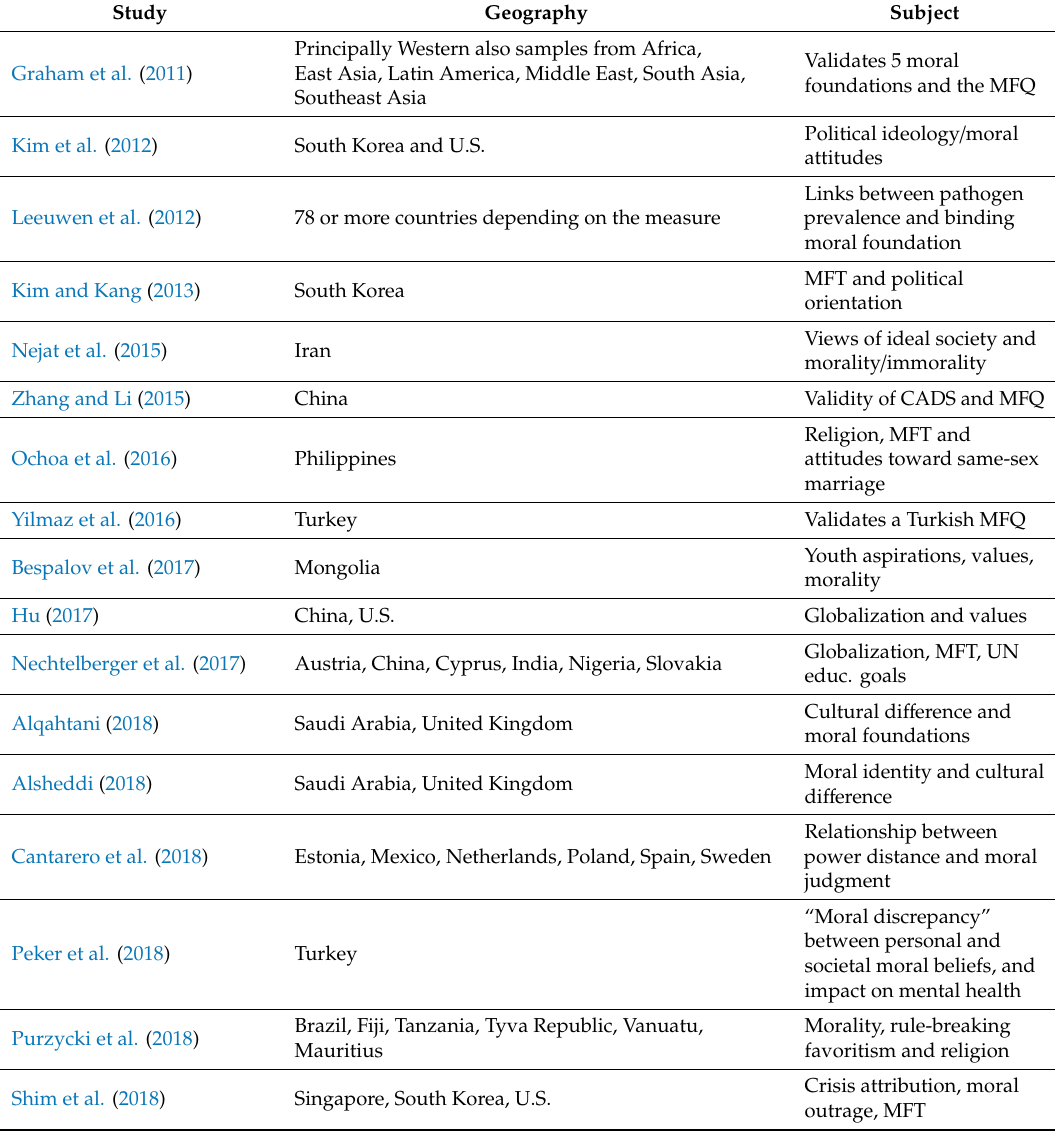
Table 5. Research with Moral Foundations Questionnaire / Theory (MFQ / MFT) beyond Western settings.